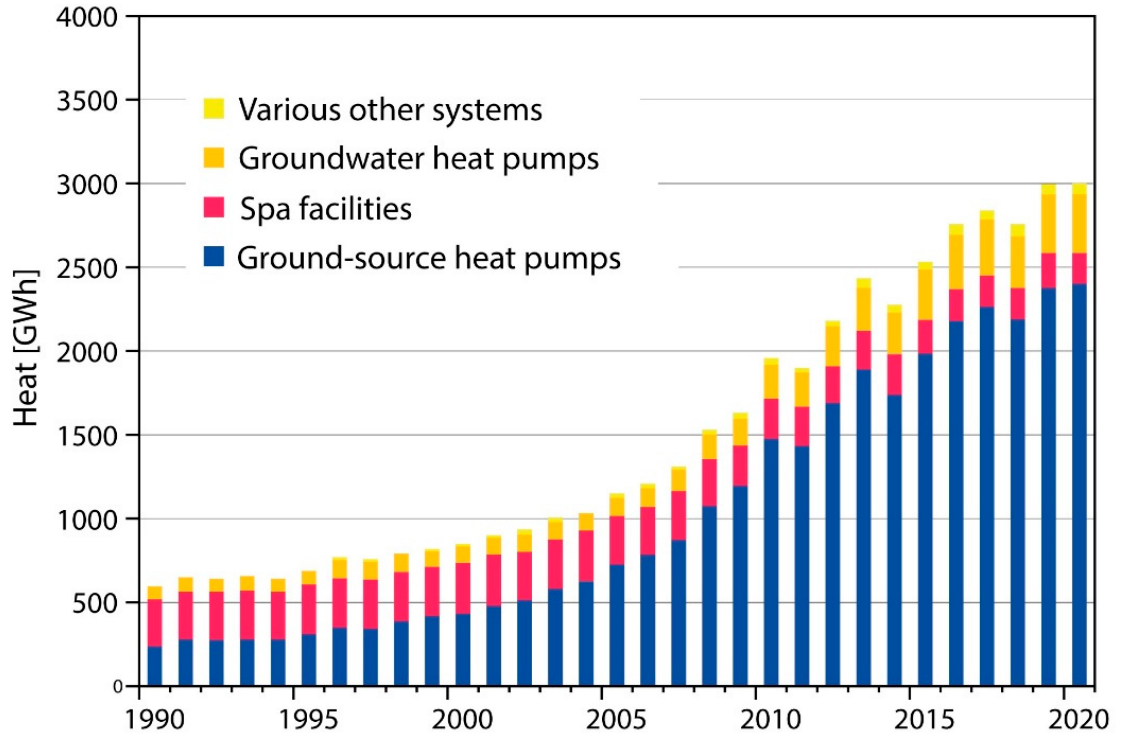
Figure 15. Development of geothermal direct use in Switzerland: Nearly exponential growth of heat delivery over three decades (by about 8% per year). The growth is due to GHP systems only. Data from [25] are plotted.